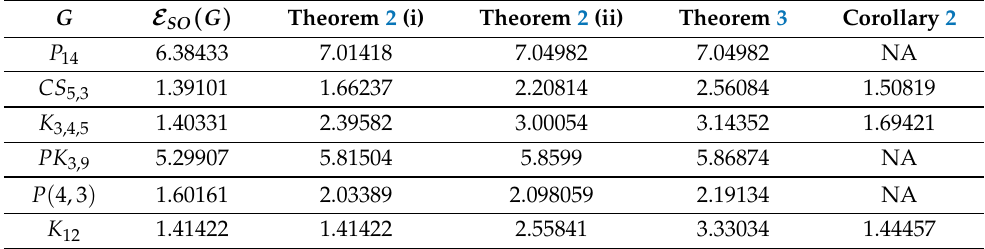
Table 2. Modified Sombor energy and the approximate values of the upper bounds obtained in this article.